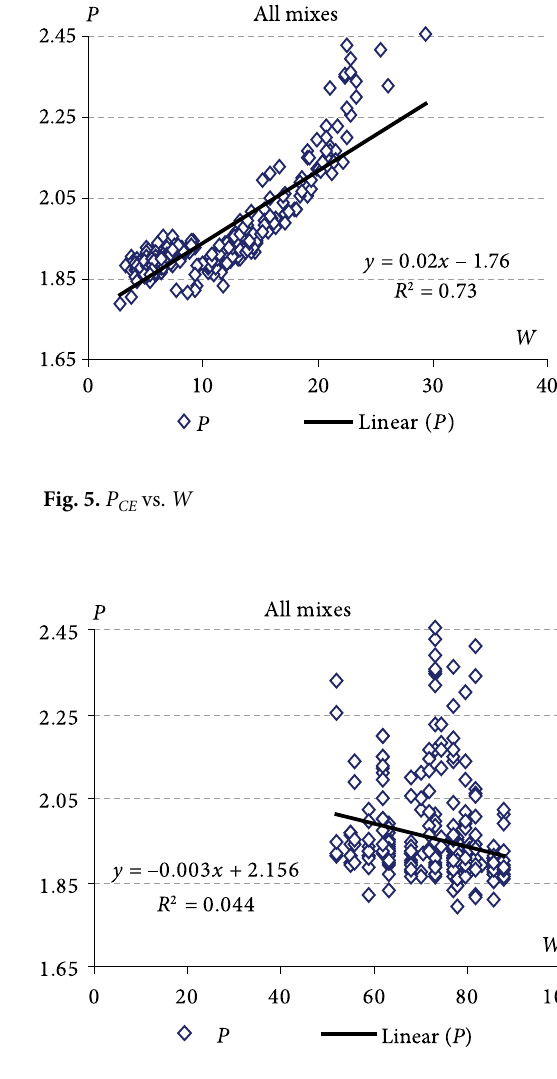
Fig. 7. P CE vs. W OA